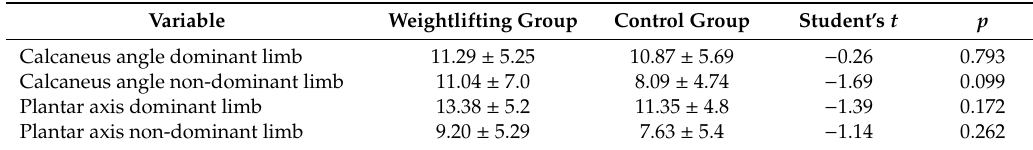
Figure 1. Foot type in both groups. Table 2. Static calcaneus angle and plantar axis of the dominant and non-dominant limb and between-group comparisons (Student’s t and p value).